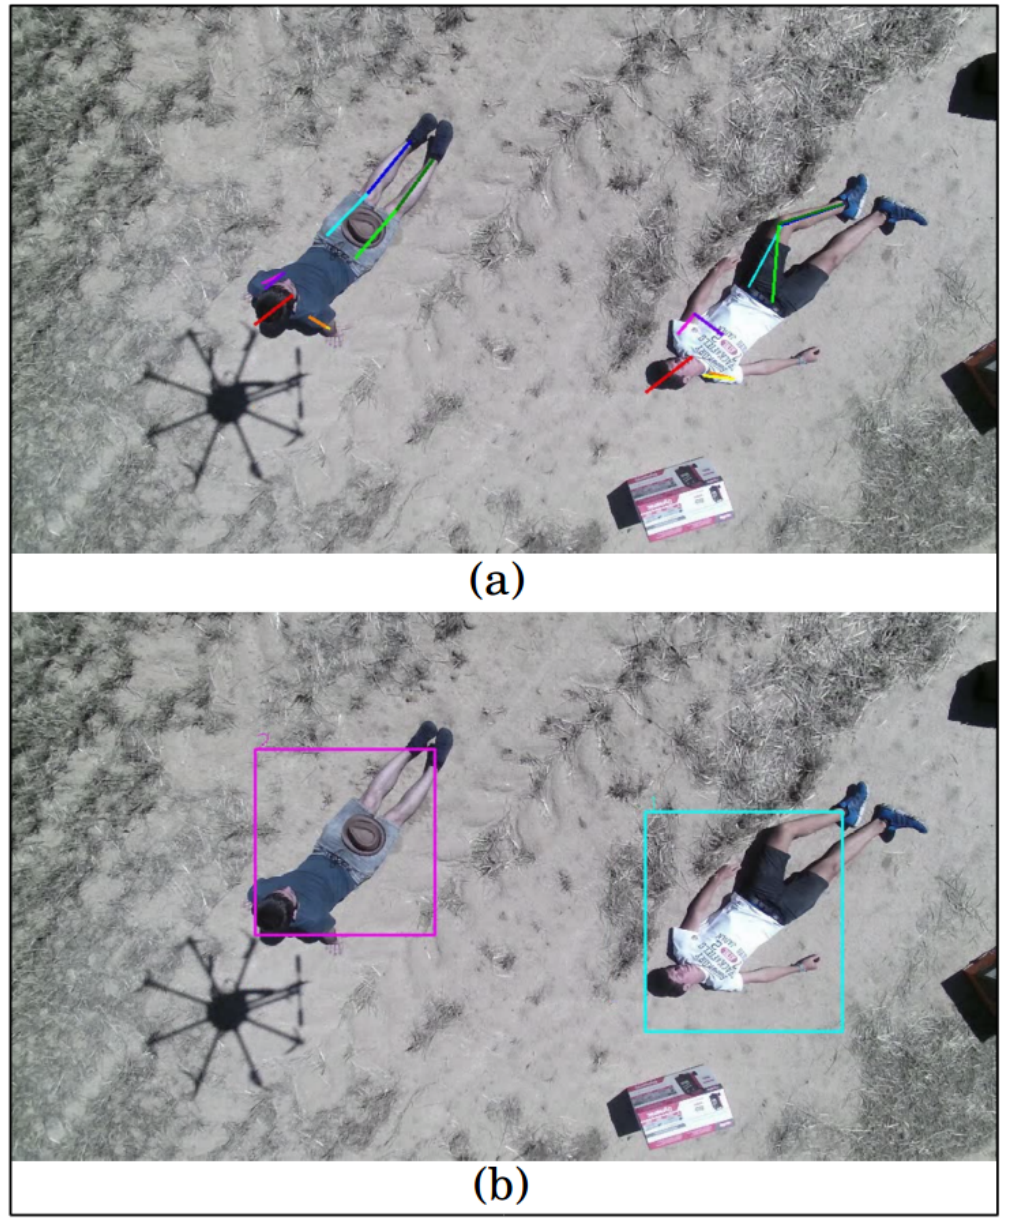
Figure 5. Multi-object tracking (MOT) algorithm output: ( a ) pose structures representation of the detected human objects, ( b ) updated tracks bounding